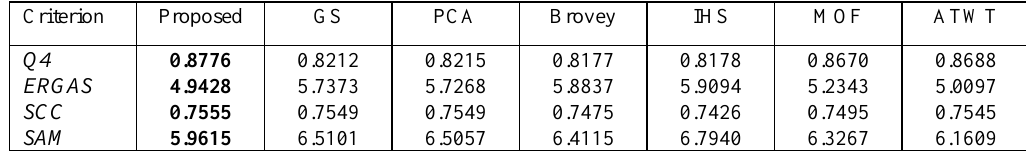
Table 1. Quantitative comparative evaluation results of WorldView-2.